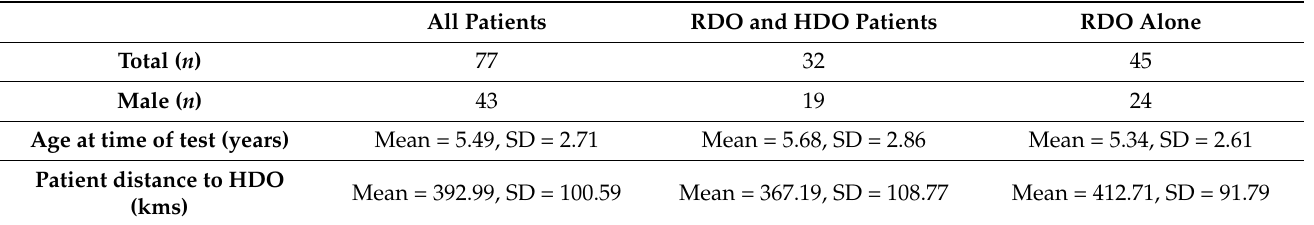
Table 2. Demographics: The number of patients and their age, sex, and distance from the hospital- delivered oximetry (HDO) location are shown.